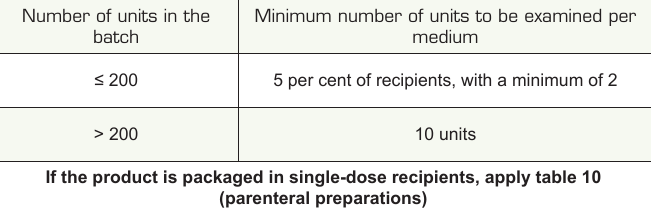
If necessary, it is possible to top up to 100 ml with an appropriate sterile diluent (for example a neutral solution of meat or casein peptone at 1g/l). Except where justified as an exception, the total volume filtered through the same membrane must not exceed 1,000 ml (European